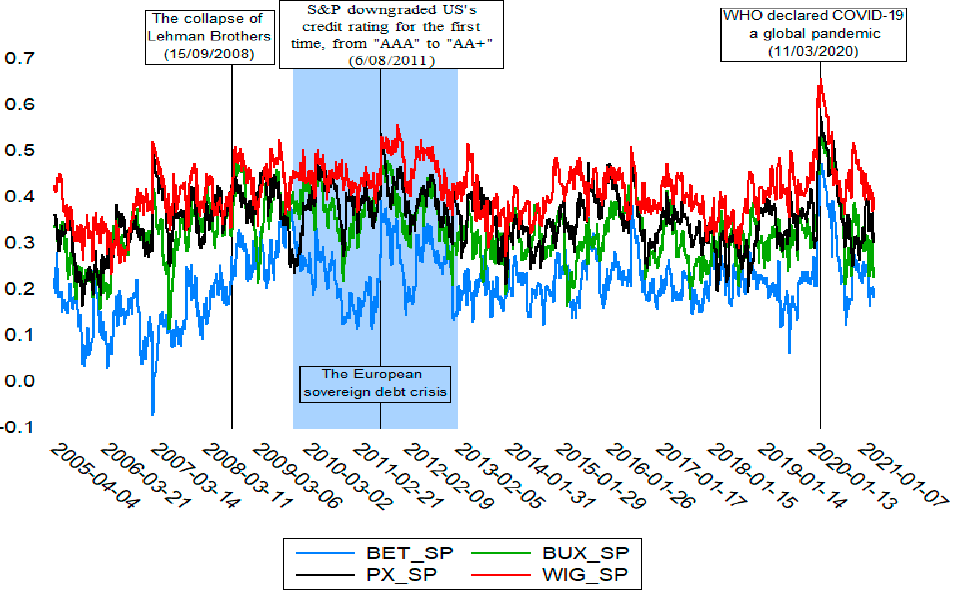
Figure 2. The evolution of the conditional correlation coefficients between the CEEC indices and the S&P500 index.